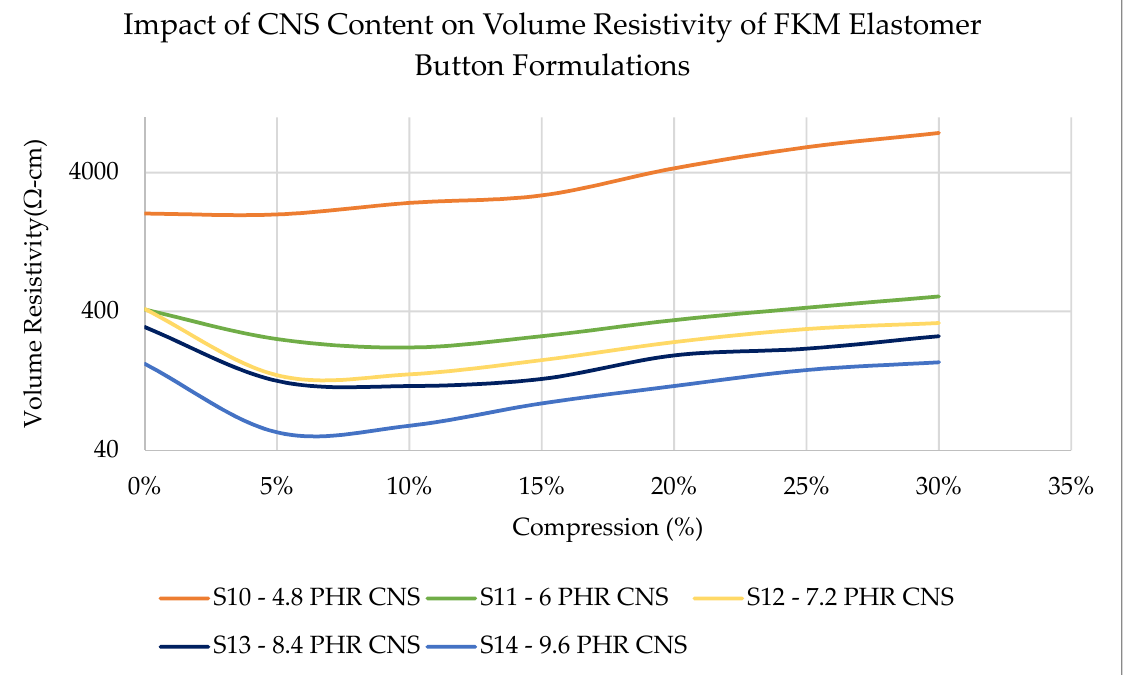
Figure 4. Effect of CNS content within elastomer buttons on volume resistivity across multiple compression levels.